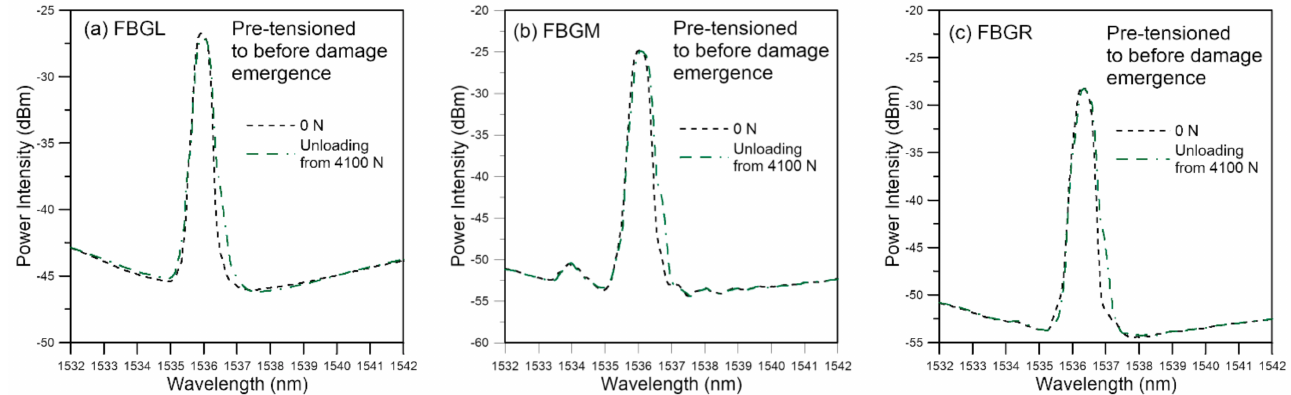
Figure 11. Unload spectra of fatigue specimen pre-tensioned to before damage emergence.